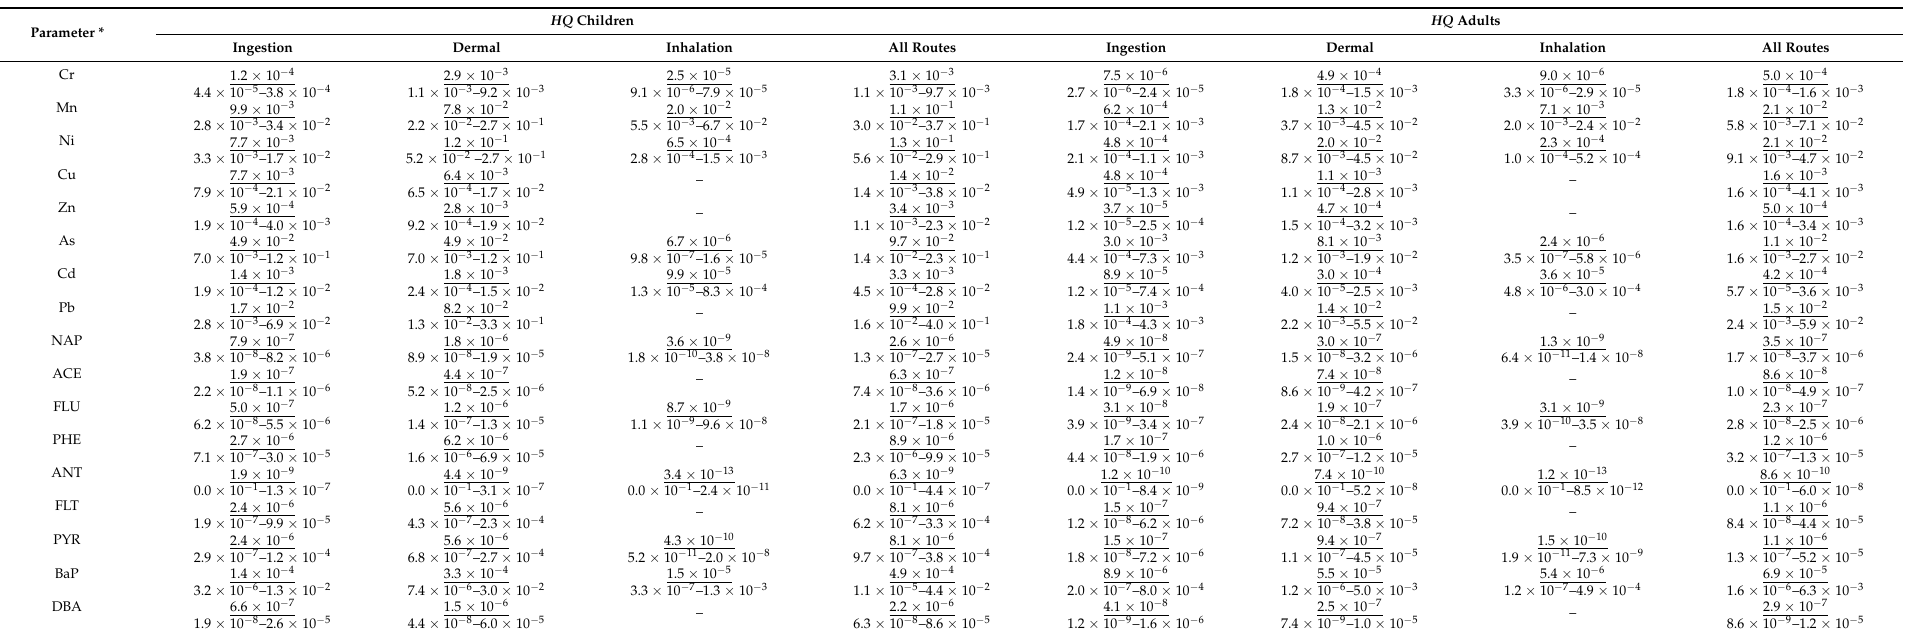
Table A1. Hazard quotient ( HQ ) for adults and children attributed to the PTEs in topsoils of the Lower Don and the Taganrog Bay coast (n = 86). HQ Children HQ Adults Parameter* Ingestion Dermal Inhalation AllRoutes Ingestion Dermal Inhalation